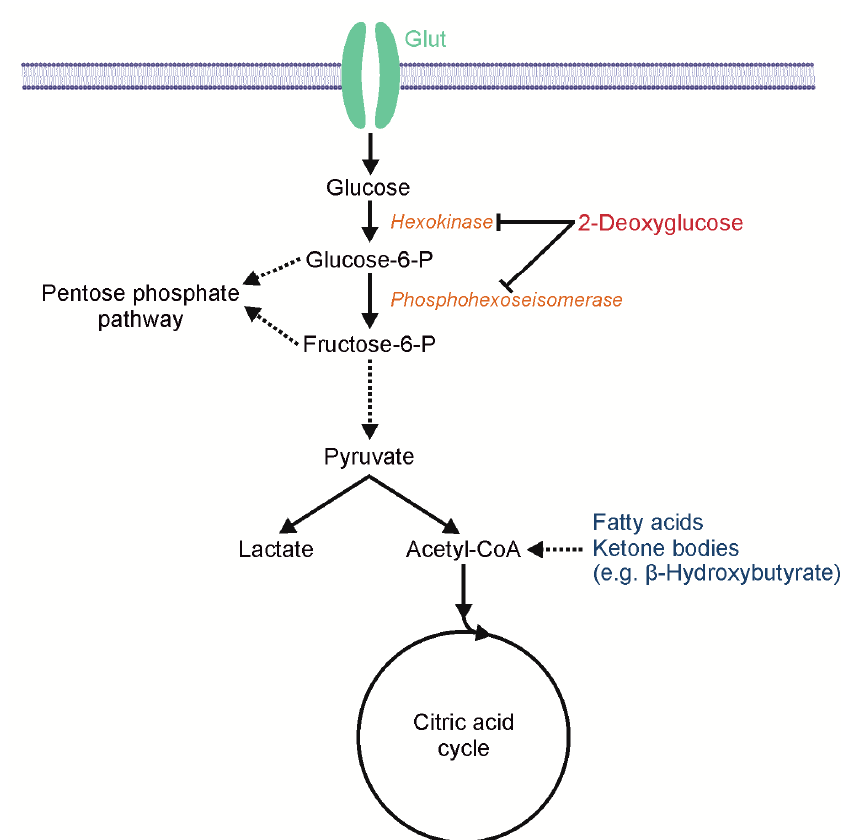
Figure 1. Scheme of 2-deoxyglucose (2-DG)-mediated metabolic effects. 2-deoxyglucose (2-DG) inhibits glycolysis by blocking hexokinase and phosphohexoseisomerase. Fatty acids and ketone bodies, for example β -hydroxybutyrate, enter the metabolic pathway downstream of this block and thus enable the citric acid cycle and oxidative phosphorylation.